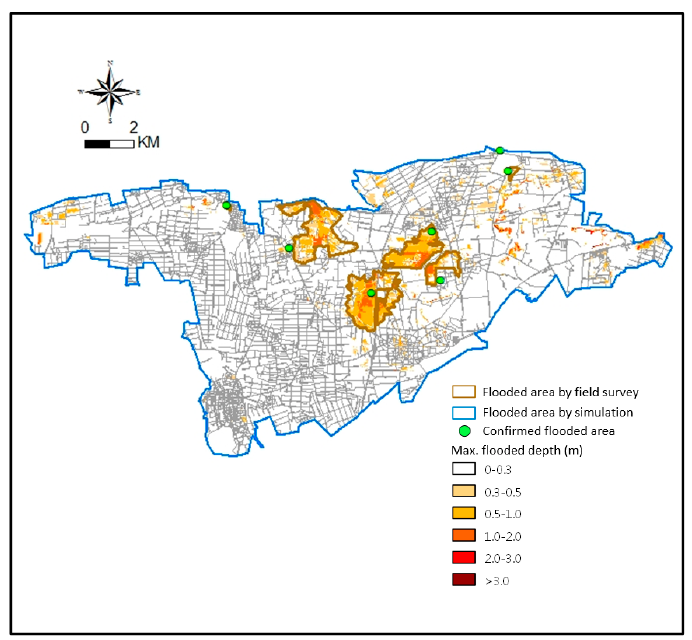
Figure 10. Validation of flood simulation for Jiangjun watershed after Typhoon Kongrey in August 2013.